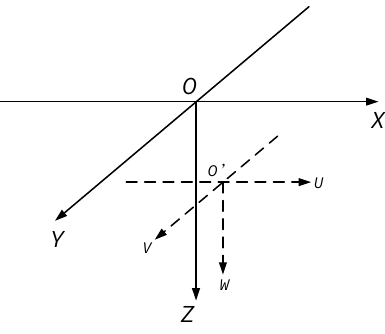
Figure 6. Coordinate transformation.